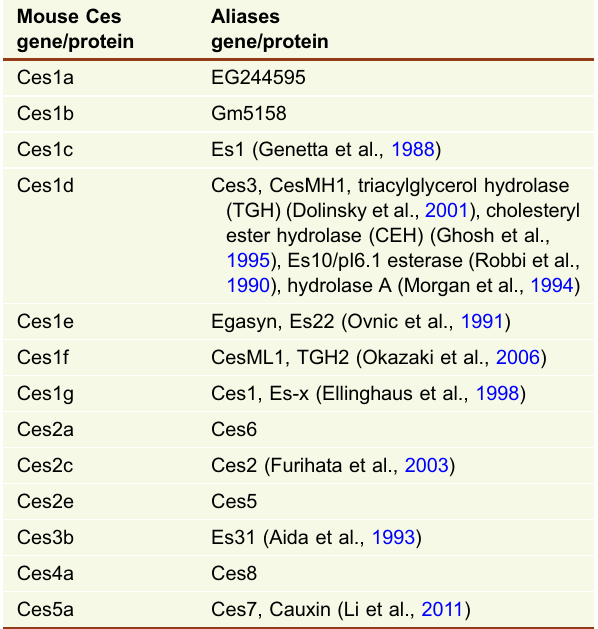
Table 1. Aliases of mouse carboxylesterases Mouse Ces gene/protein